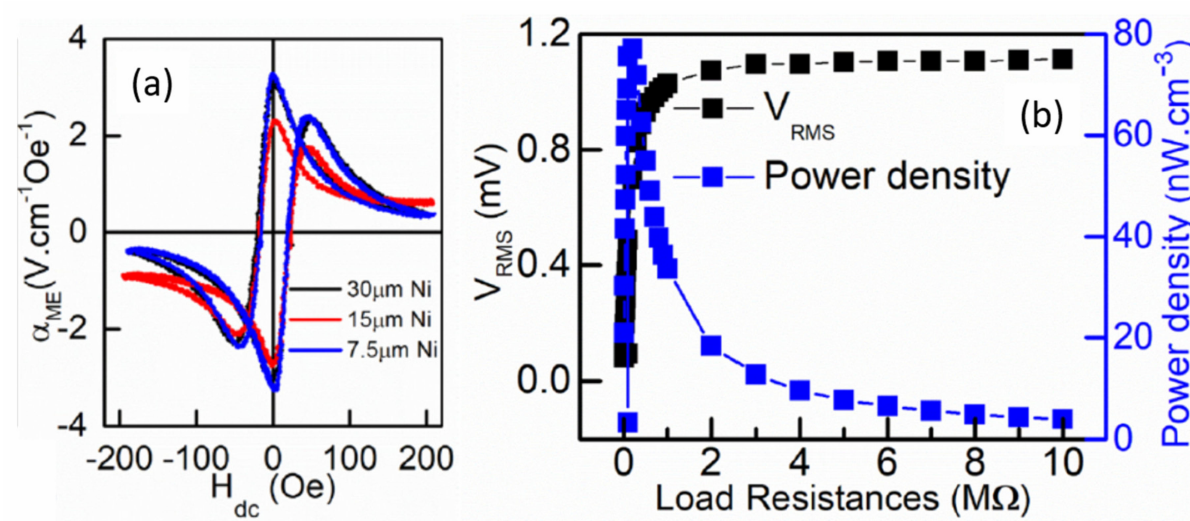
Figure 16. ( a ) ME voltage coefficient as a function of H dc at H ac = 8.5 Oe, for different Ni foil thickness. ( b ) Off